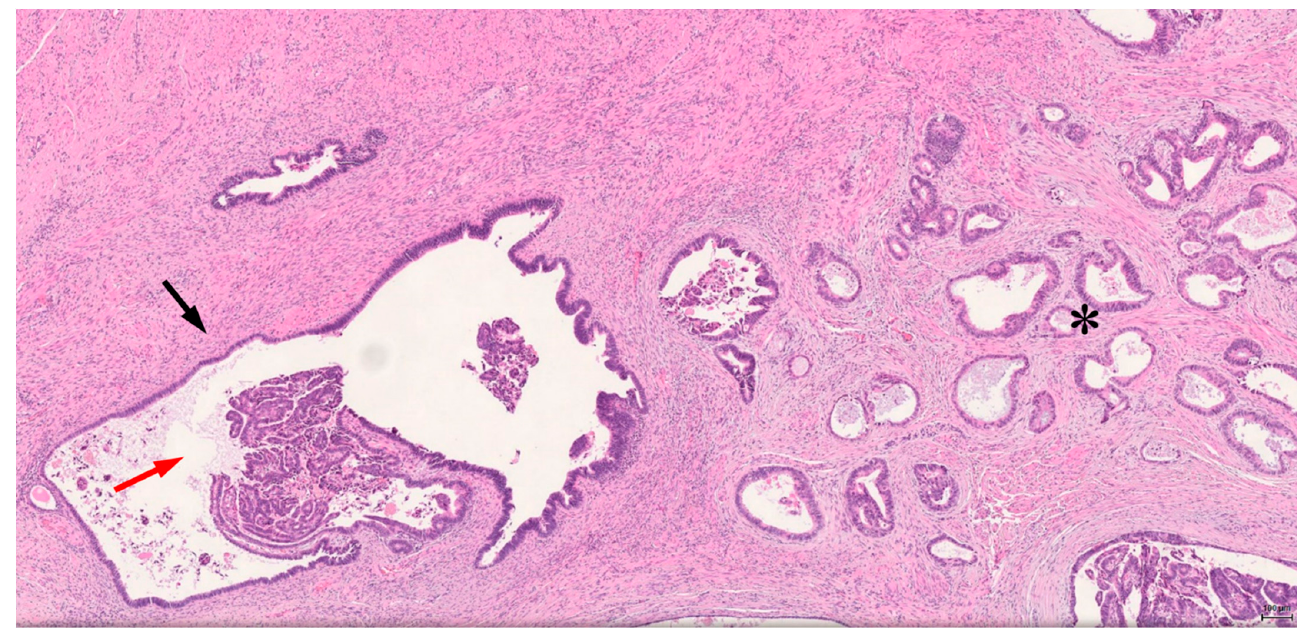
Figure 2. Histology of the resected tissue. Transition between cystic endometrioid gland with bland cytologic atypia (black arrow), and malignant transformation of atypical endometriosis (red arrow) and invasive endometrioid adenocarcinoma (*). (HE, ×40) .